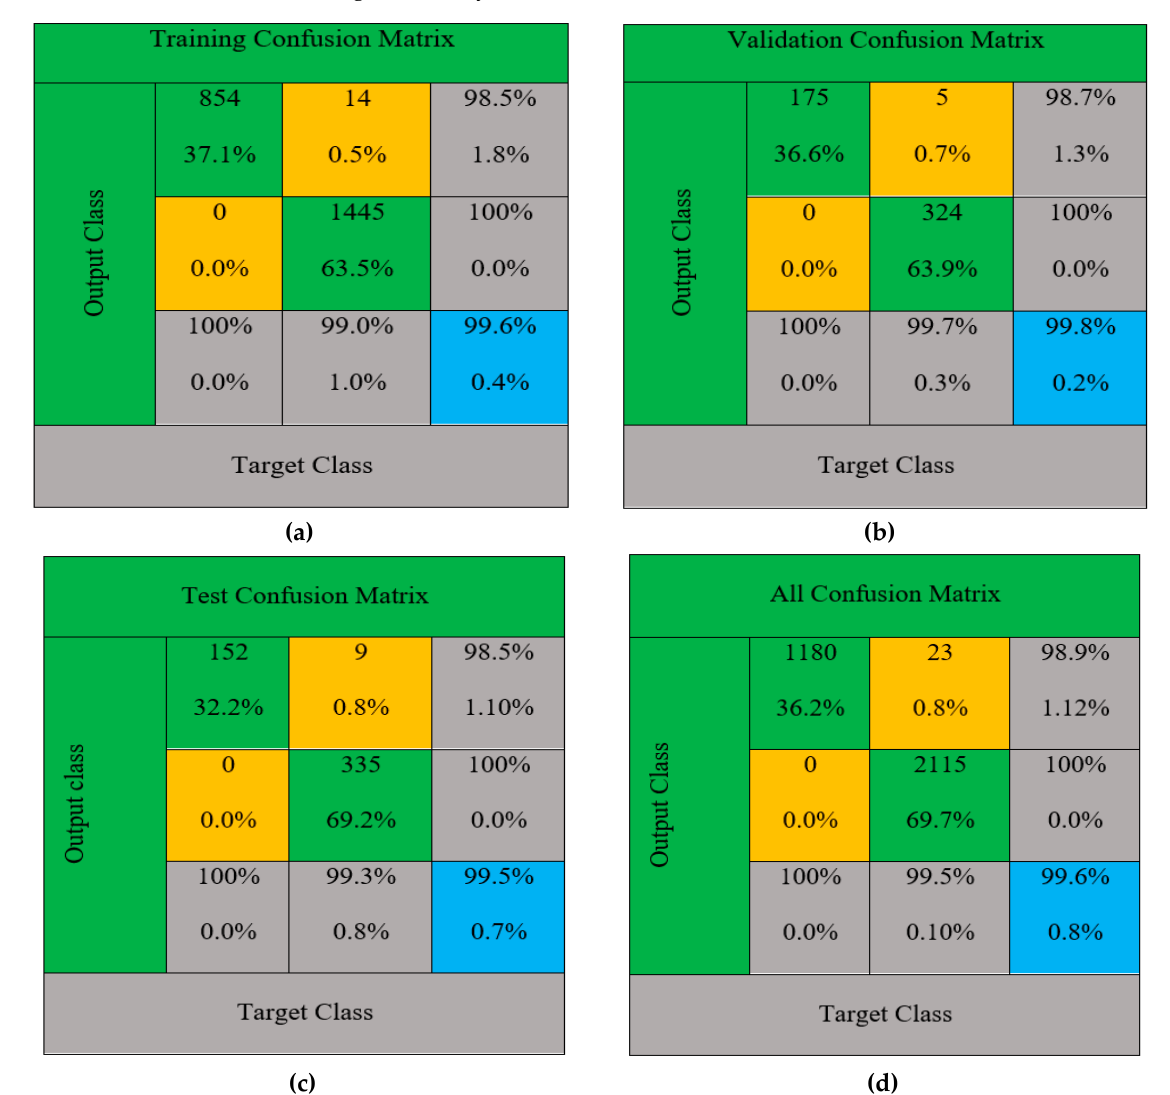
Table 3. Data sample description.